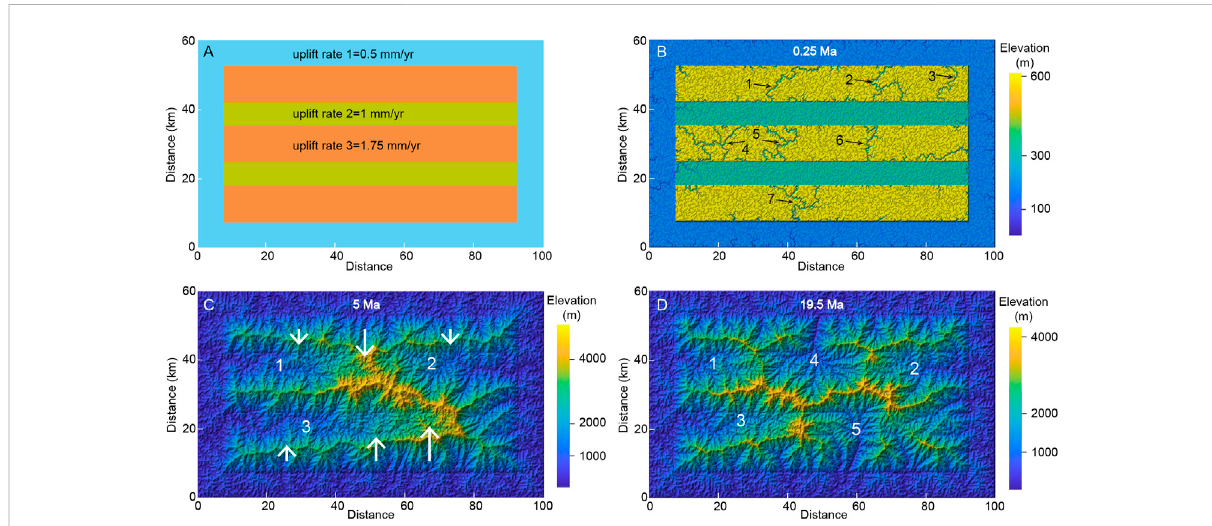
FIGURE 8 Setup of uplift patterns (A) and simulation results for drainage pattern evolution in the active fold-thrust belt (B – D) . The numbers in Figure 7B mark themain rivers;thenumbersinFigure 8 (C,D) markthemain drainage basins;and thewhite arrows show thedirectionand magnitude ofdivide migration in Figure